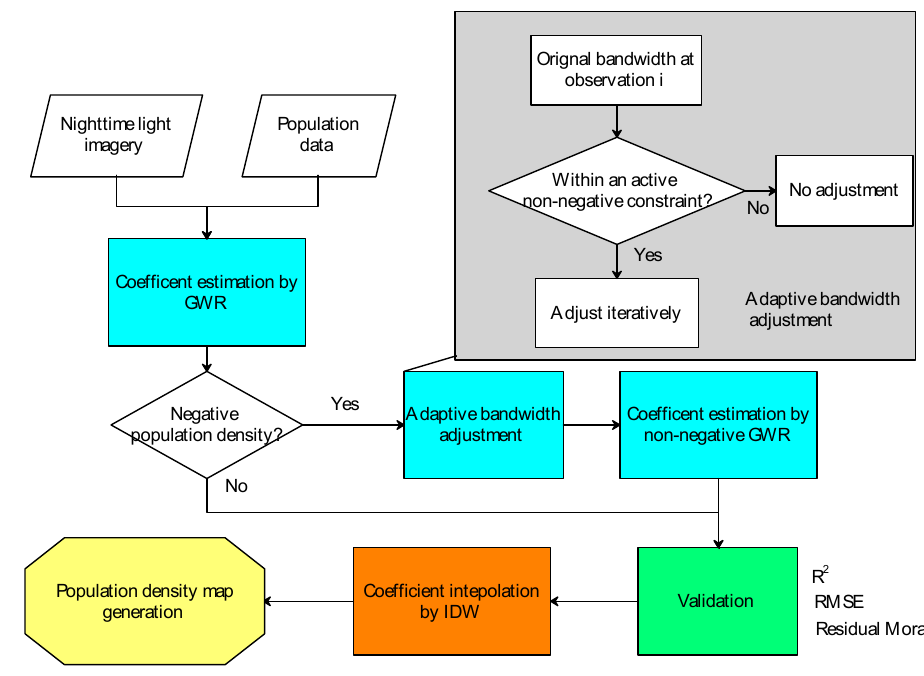
Figure 2. Flowchart of ANNGWR in the study.